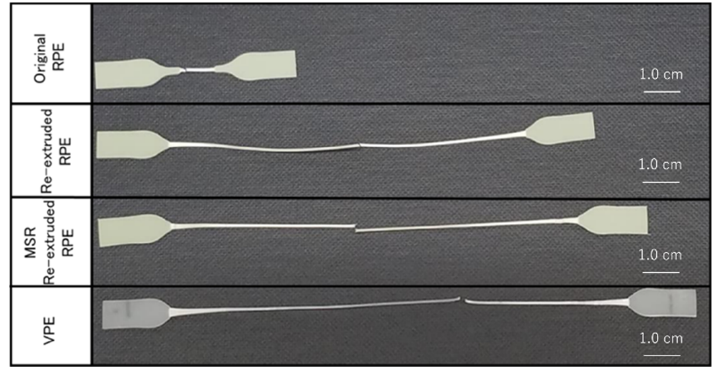
Figure 4. Representative digital photographs of the elongated tensile specimens (from top to bottom: Original recycled polyethylene (RPE), re-extruded RPE, molten resin reservoir (MSR) re-extruded RPE, and virgin PE (VPE).